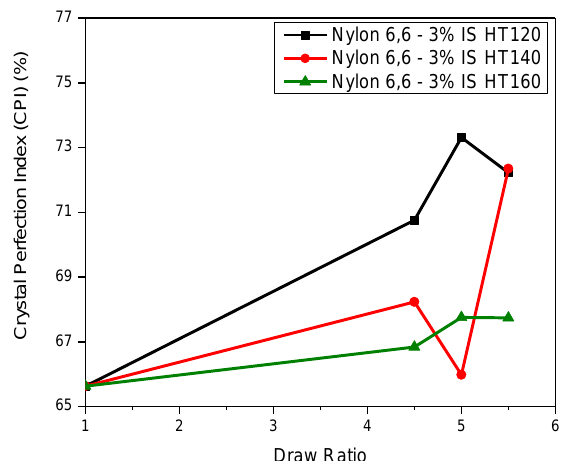
Figure 10. The CPI of the salt-confined nylon 6,6 fibres versus the drawing ratio at different drawing temperatures.